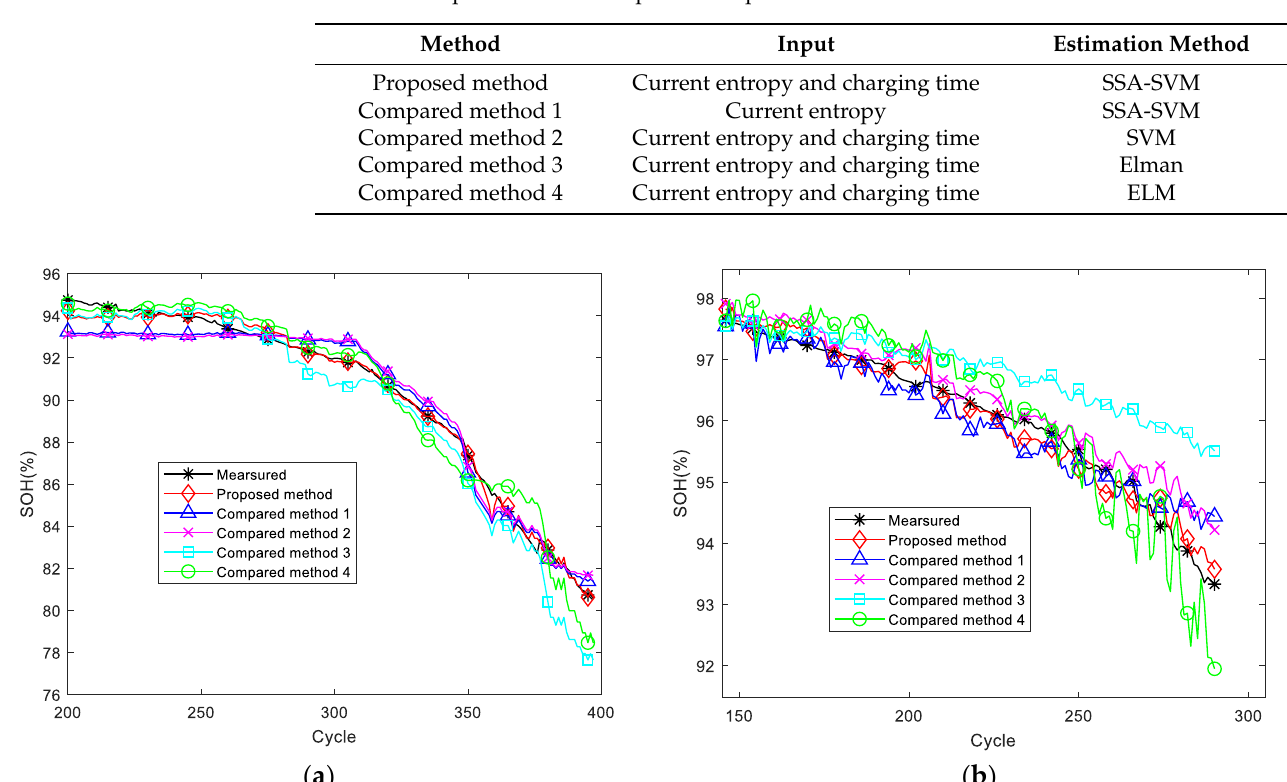
( b ) Figure 8. The SOH bar errors between estimation and measurement. ( a ) Battery pack; ( b ) battery cell. In order to prove the feasibility of the SOH estimation method, we set up four com- parative experiments. Comparative experiment 1 was observed from the perspective of the dimension of the input features. Comparative experiment 2 contrasted from the per-